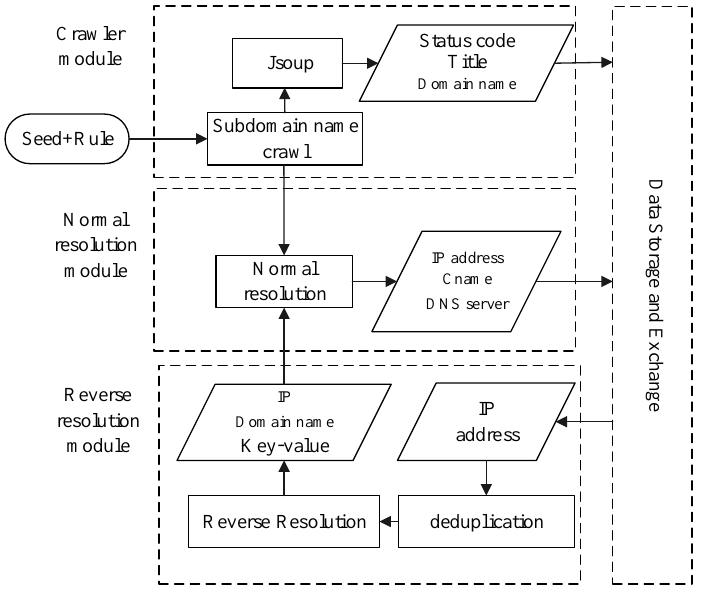
Figure 3. Flow diagram of network asset